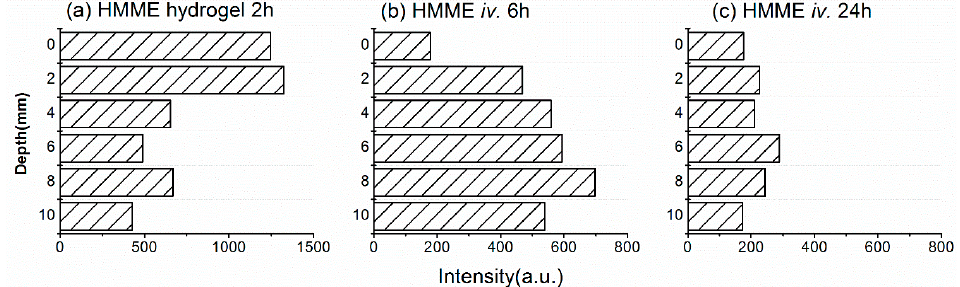
Figure 7. Distribution of hematoporphyrin monomethyl ether (HMME) in tumors measured by fluorescence spectrometry. Tumors were analyzed as described for Figure 5. ( a – c ) HMME distribution at 2 h after application of a hydrogel to the skin ( a ) and at 6 h ( b ) and 24 h ( c ) after intravenous administration in phosphate-buffered saline.